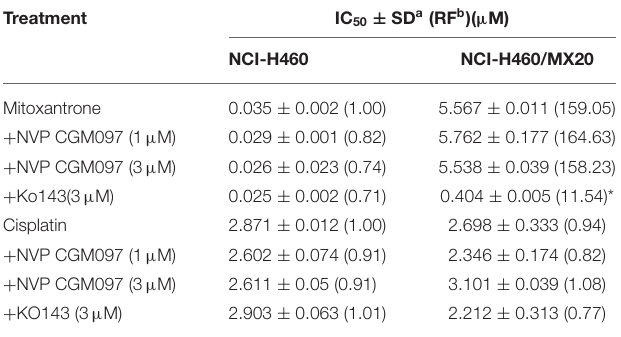
TABLE 3 | NVP-CGM097 did not affect ABCG2-mediated MDR. Treatment